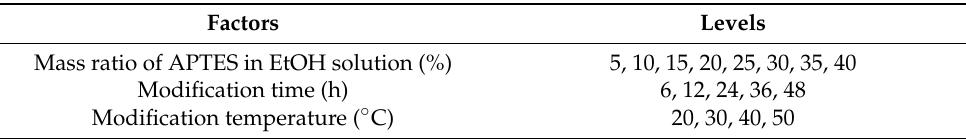
Table 1. List of the factors and their levels for surface modification. Factors Levels Mass ratio of APTES in EtOH solution (%) 5, 10, 15, 20, 25, 30, 35, 40 Modification time (h) 6, 12, 24, 36, 48 Modification temperature ( ◦ C) 20, 30, 40,